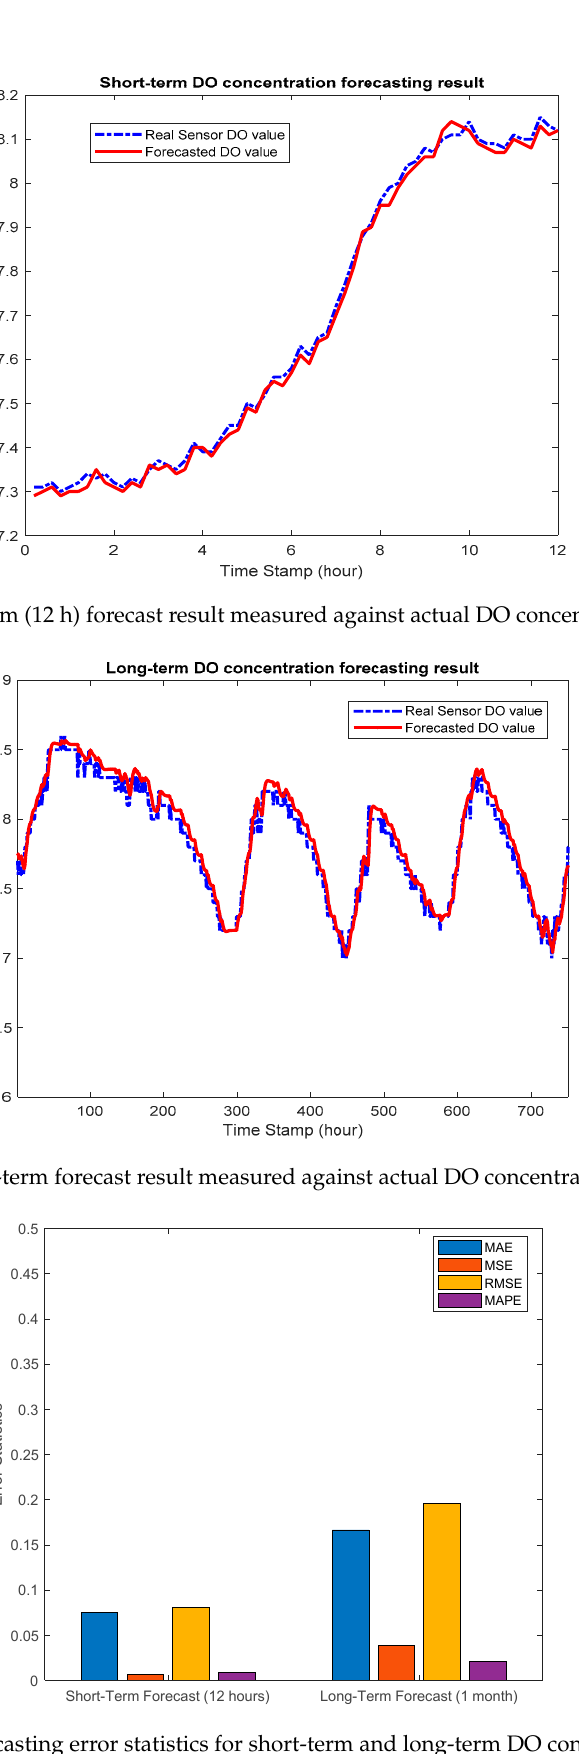
Figure 9. Forecasting error statistics for short-term and long-term DO concentration.